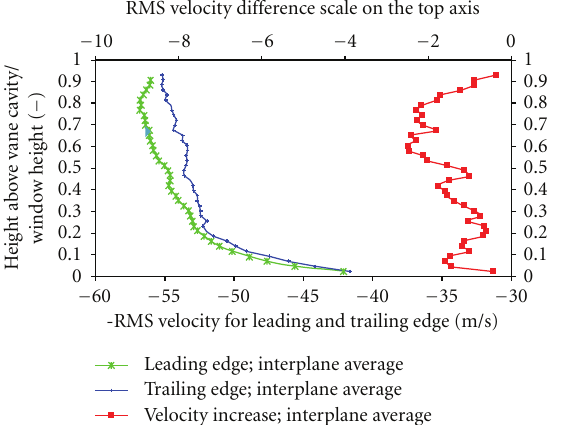
Figure 17: Velocity profile over RVC for curved (right) configura- tion, 1.5 kg/min main